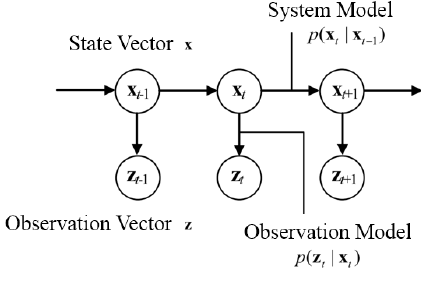
Figure 1. General state space